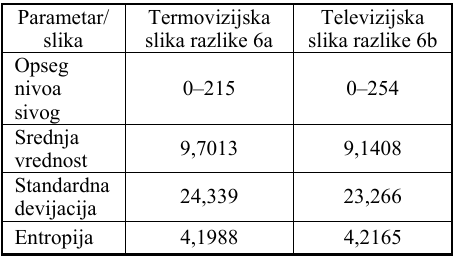
Opseg nivoa sivog, srednja vrednost,